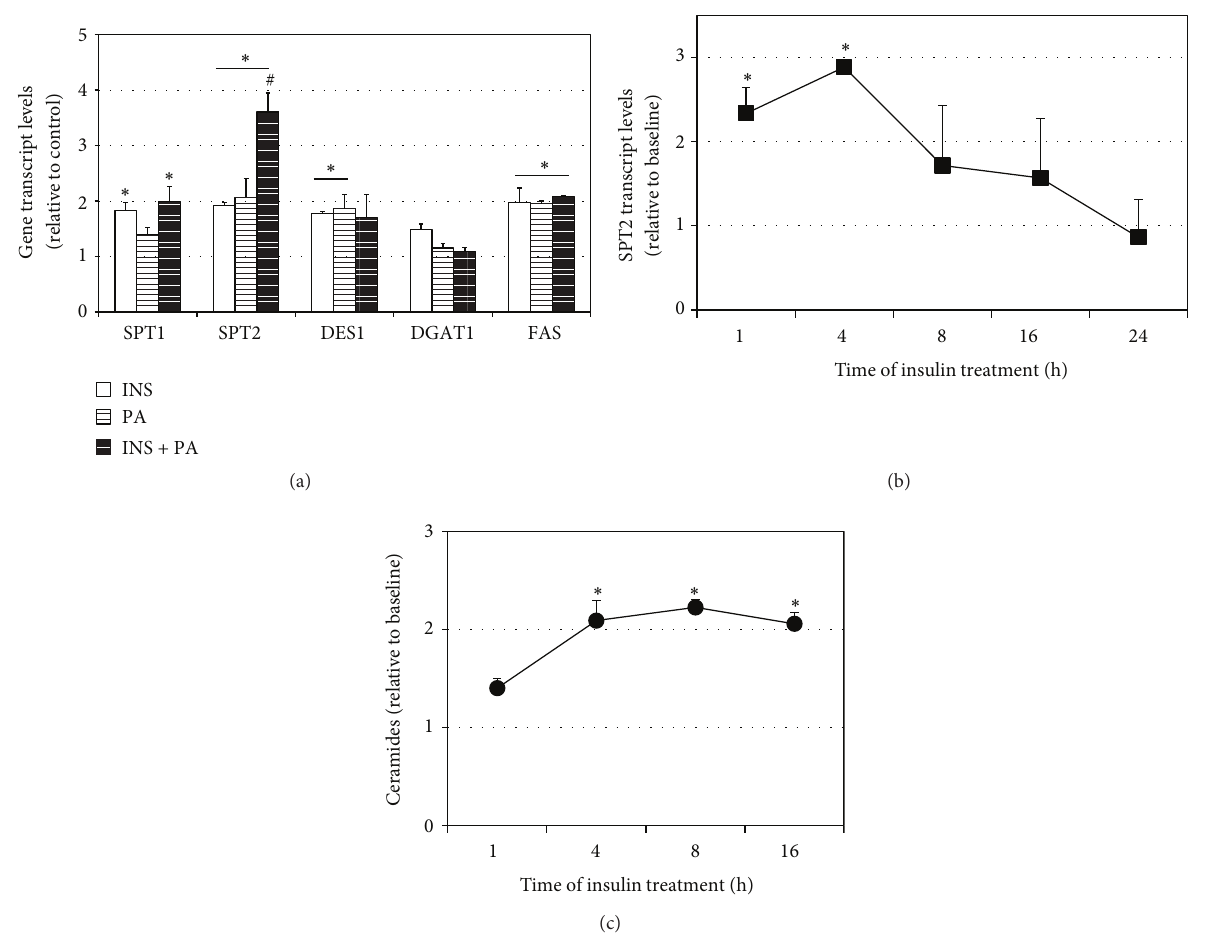
Figure 2: Murine myotubes were treated with insulin (50 nM) with or without palmitic acid (PA, 0.5 mM) for 16 h. (a) Following treatment, expressions of multiple enzymes involved with ceramide (SPT1, SPT2, and DES1) and TAG (DGAT1, FAS) metabolism were quantified. ∗ 𝑃 < 0.05 , treatment versus control. # 𝑃 < 0.05 , INS + PA versus other treatments. (b) The time course of insulin treatment (50nM) revealed that SPT2 gene expression was significantly increased at 1 h and peaked at 4 h. ∗ 𝑃 < 0.05 , treatment versus control. (c) The time course of insulin treatment (50nM) revealed that ceramides were significantly increased at 4 h and sustained through 16h. ∗ 𝑃 < 0.05 , treatment versus control.